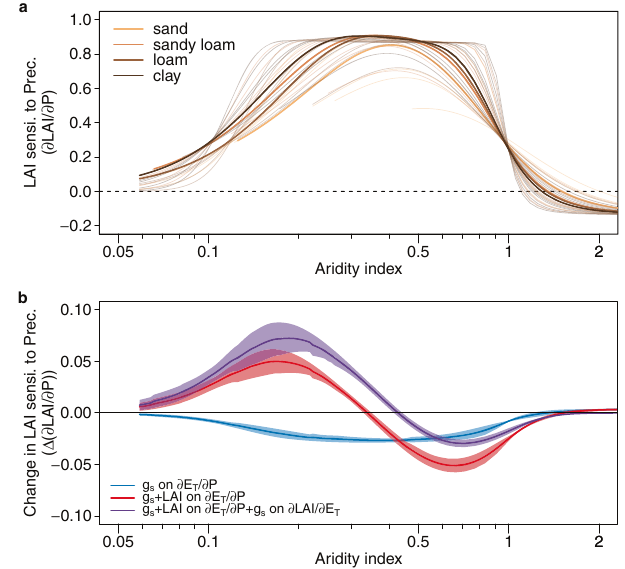
Fig. 4 | Predicted responses of vegetation sensitivity by the minimalistic hydrological model. a predicted responses along the aridity index. Different line colors represent different soil types, with thicker lines indicating the estimates based on global land mean values for rooting depth and rainfall depth. Thin lines indicate estimates using other possible value combinations (Supplementary Table3). b predictedchangesofsensitivityduetoelevatedatmosphericCO 2 .Three types of CO 2 effect are considered, with each line represents a stepwise combina- tionofthem(seeMethods).Thesolidlineswithshadedareasindicatetheensemble mean and standard deviation of all soil and climate combinations. The results are obtained assuming all vegetation are